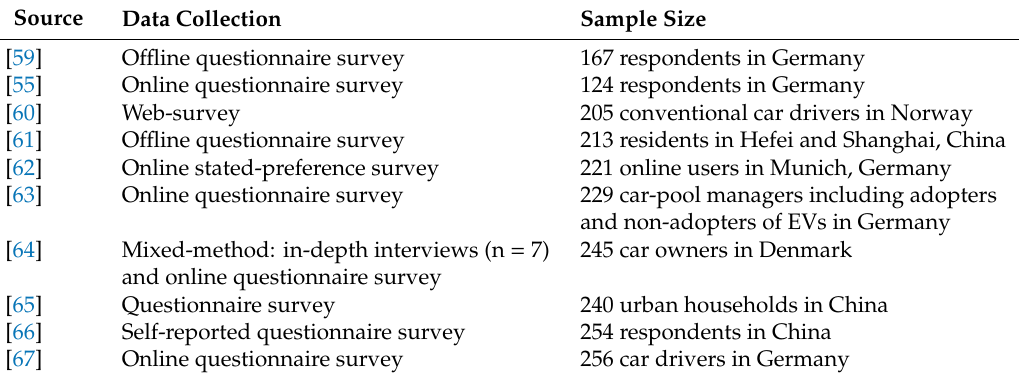
Table 1. The summary of studies related to the adoption of pro-environmental / new energy vehicles. EVs, electric